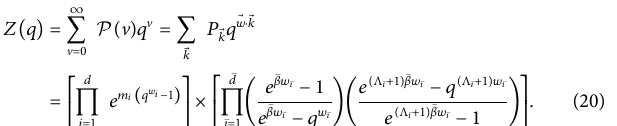
FIGURE 1 The probability to own more than mean value m : (cid:9) k > m P p ( m, k ) (Poisson for distinguishable wealth, red) vs. (cid:9) k > m (cid:2) P b ( m , k ) (geometric for identical wealth, blue), with varying mean value m (horizontal axis). The former is always larger than the latter. They converge to 1/2 and e − 1 ≃ 0.367879 in the large m limit (25).